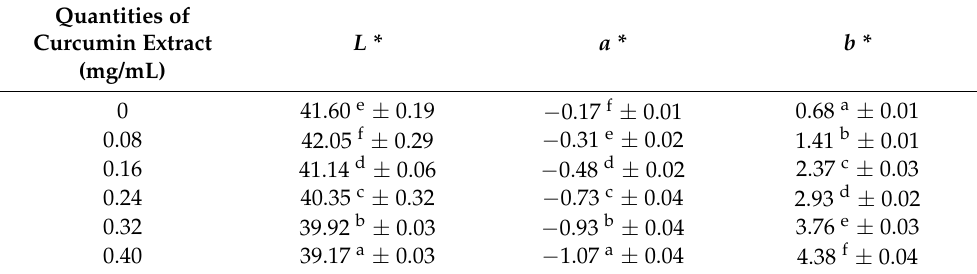
Figure 2. Chitosan-based films incorporated with different concentrations of curcumin extract (C CE ). ( a ) C CE = 0 mg/mL, ( b ) C CE = 0.08 mg/mL, ( c ) C CE = 0.16 mg/mL, ( d ) C CE = 0.24 mg/mL, ( e ) C CE = 0.32 mg/mL, ( f ) C CE = 0.40 mg/mL. Table 2. Color parameters ( L*, a* , and b* ) of chitosan films incorporated with curcumin extract. Quantities of Curcumin Extract (mg/mL)